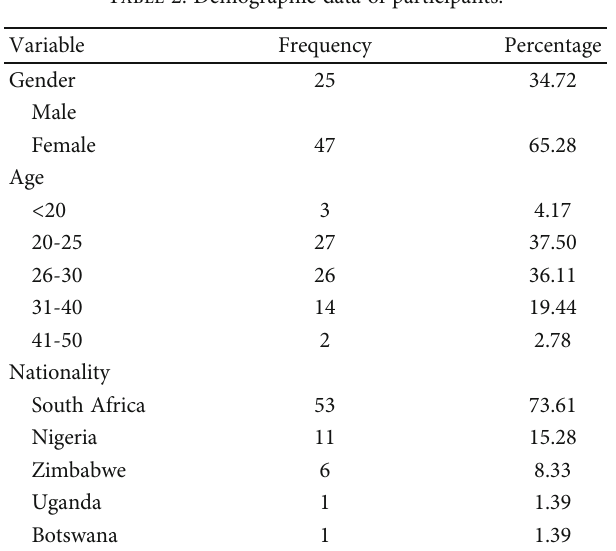
Table 2: Demographic data of participants.